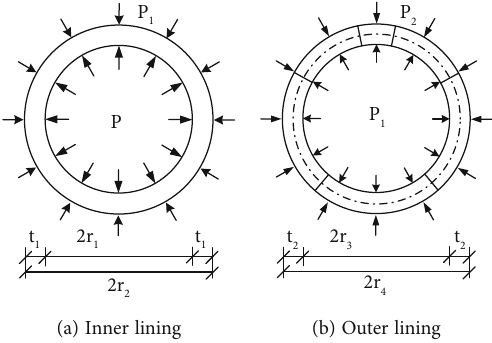
Figure 3: Analysis model of inner and outer linings.